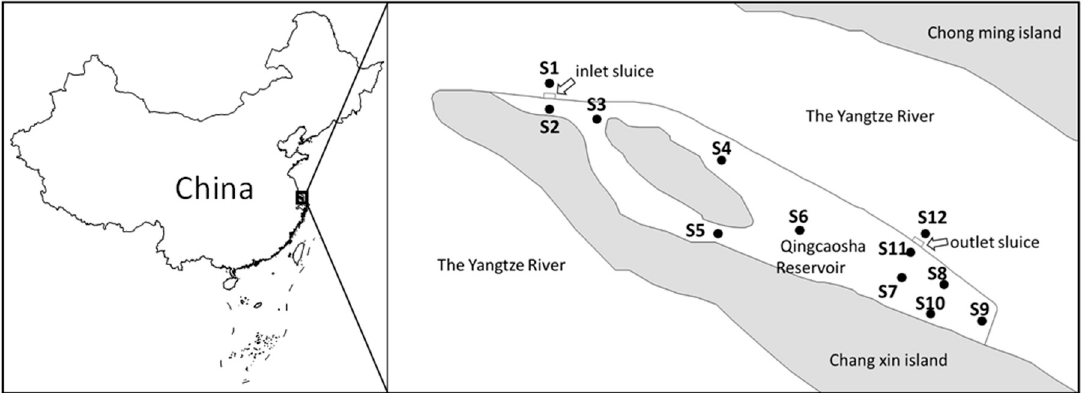
Figure 1. Location of the reservoir and distribution of sampling stations along the northern tributary of the Yangtze River. S1 represents the inlet sluice and S12 represents the outlet sluice, and S2 to S11 are located inside the reservoir.